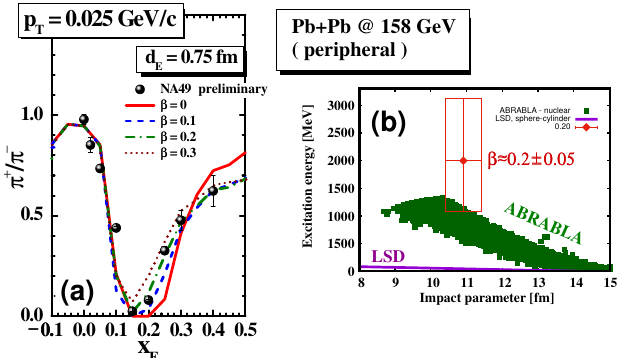
Figure 2. (a) π + /π − ratio in peripheral Pb + Pb reactions [11], compared to model simulations described in the text, with the distance d E set to 0.75 fm and di ff erent values assumed for the spectator expansion surface velocity β . (b) Theoretical calculations of spectator excitation energy [14], compared to the kinetic energy of the expanding sphere described in the